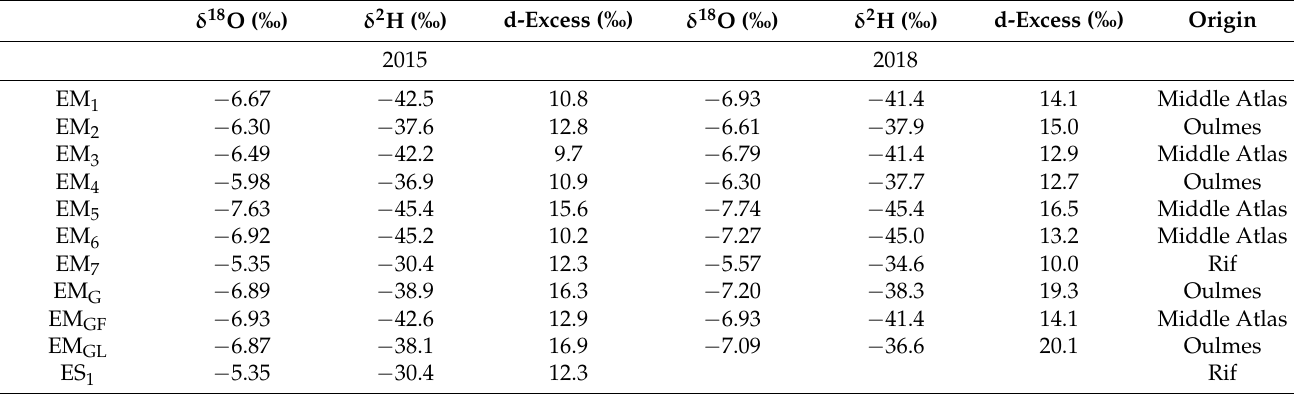
Table 4. Composition in δ 18 O and δ 2 H in 2015 and